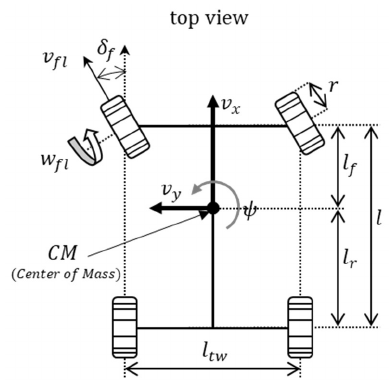
Figure 5. Vehicle wheel scheme.